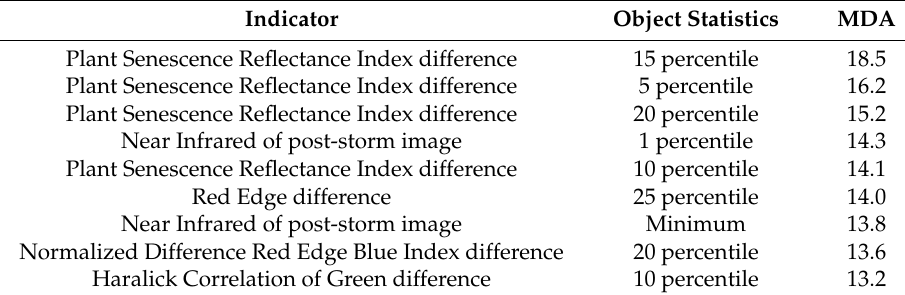
Table 10. Random Forest model with the most important object variables for the Munich South study site. The last column indicates the value of the Mean Decrease in Accuracy (MDA).